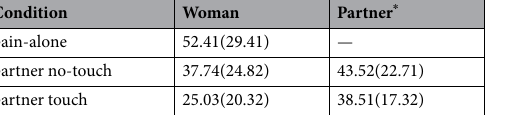
Table 1. Average (standard deviation) pain ratings in each condition. * The male partner guessed the woman’s Model for male participants: How changes in respiration in females predict shifts in changes of males. The post-hoc analysis revealed a significant effect of cross-partner velocity for men during the no touch-no pain ( ζ nt(np) = 0.026, p < 0.001, 95% CI [0.016, 0.036]), touch-pain ( ζ t(p) = 0.019, p < 0.001, 95% CI [0.010, 0.027]) and touch-no pain ( ζ t(np) = 0.011, p < 0.001, 95% CI [0.005, 0.016]) conditions (Fig. 2c). Thus, an increase in the woman’s heart rate was related to a shift from a decrease to an increase in the man’s heart rate under the above-mentioned conditions. However, cross-partner female velocity during the no touch-pain condi- tion ( ζ nt(p) = 0.002, p = 0.57) was not related to acceleration in the men’s heart rate. No significant cross-partner